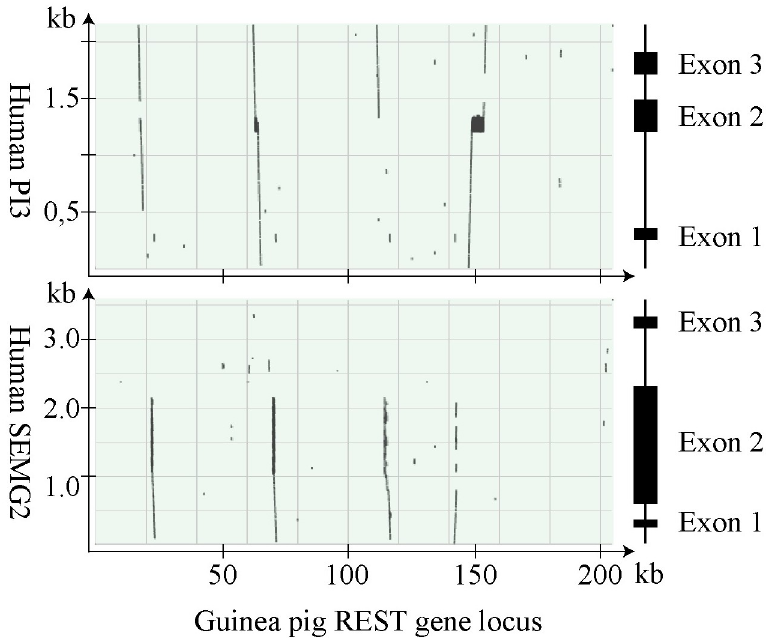
Fig 3. Dotplots showing sequence homology with SEMG2 and PI3 at the guinea pig REST gene locus. The computer program BLAST was used to align guinea pig genomic sequences, located between Slpi and Wfdc5 at the REST gene locus, and the nucleotide sequences of human SEMG2 and PI3 . The result is displayed in dotplots with illustrations to the right depicting genes with the location of exons indicated by